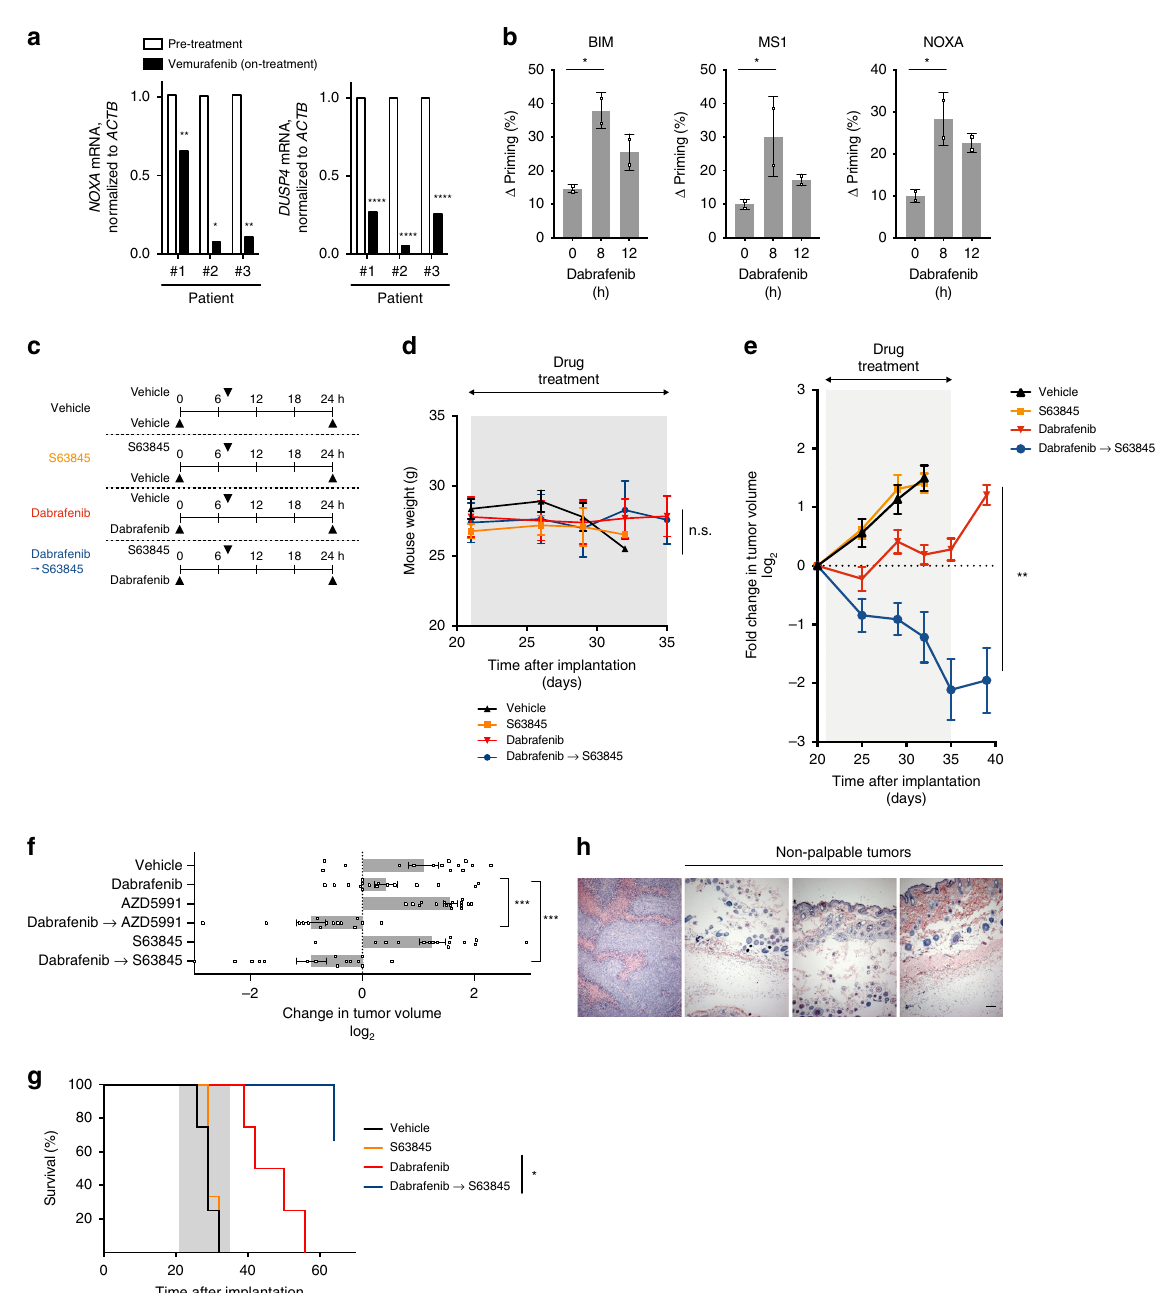
Fig. 5 Targeting apoptotic adaptation overcomes resistance to targeted therapy in vivo. a Comparison of NOXA and DUSP4 mRNA in paired biopsies obtained from melanoma patients before treatment with vemurafenib (pre-treatment) and 10 – 15 days later. Statistical comparison was done using ANOVA with Sidak ’ s multiple comparison test. ****, adjusted P value<0.0001; **, adjusted P value<0.001; *, adjusted P value<0.05. n = 1 with three technical replicates. b BH3 pro fi ling of A375M melanoma xenografts ( n = 2) following treatment with dabrafenib in vivo. BIM peptide measures BCL-2 family member